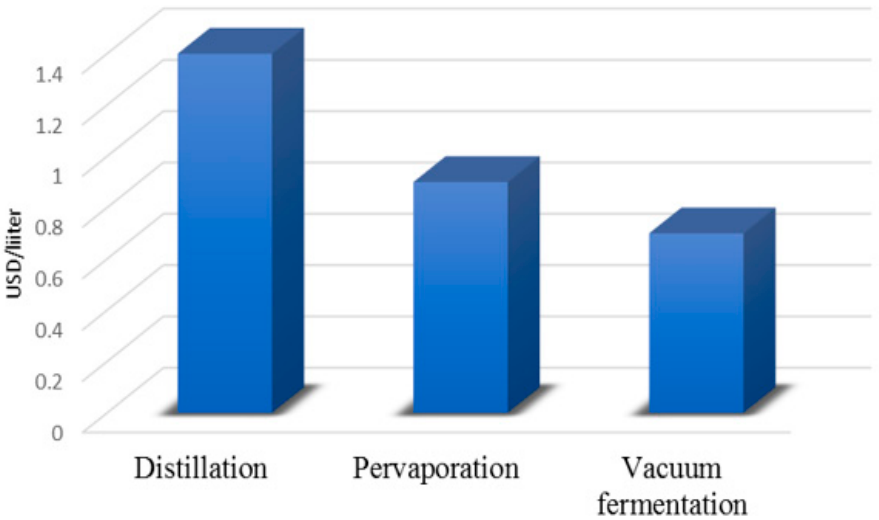
Figure 7. Evaluation of ethanol production costs using di ff erent recovery